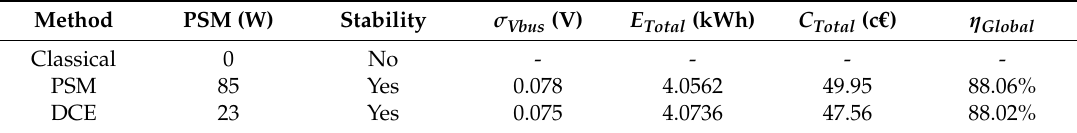
Table 2. Comparison of the three methods.